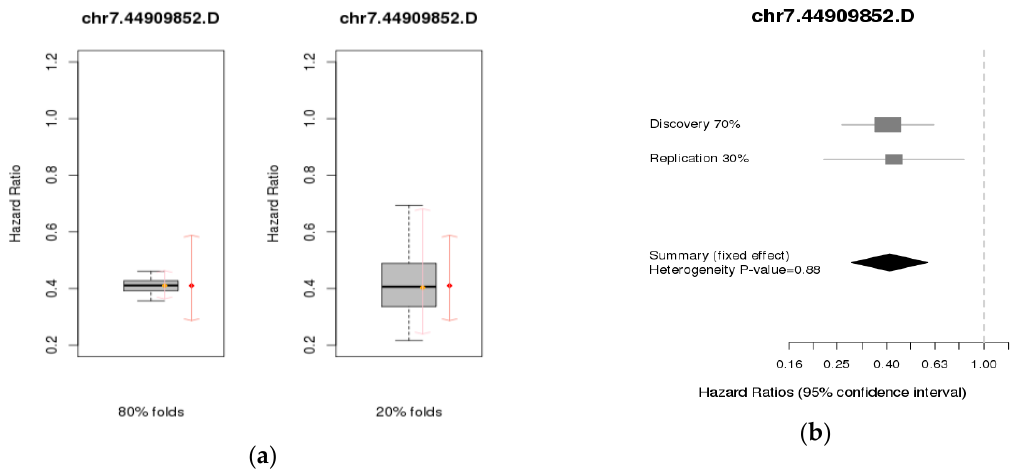
Figure 2. (a) Internal cross-validation using 80% and 20%, and (b) Internal meta-analysis using 70% Figure 2. ( a ) Internal cross-validation using 80% and 20%, and ( b ) Internal meta-analysis using 70% of of the data as discovery and 30% as replication for chr7.44909852.D. the data as discovery and 30% as replication for chr7.44909852.D.